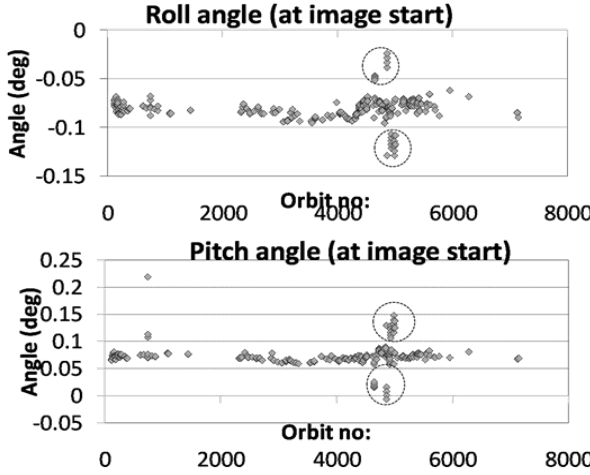
.Figure 1 Roll and Pitch angles at image start (each point represents a dataset) Roll and Pitch profiles of one such problematic data (orbit